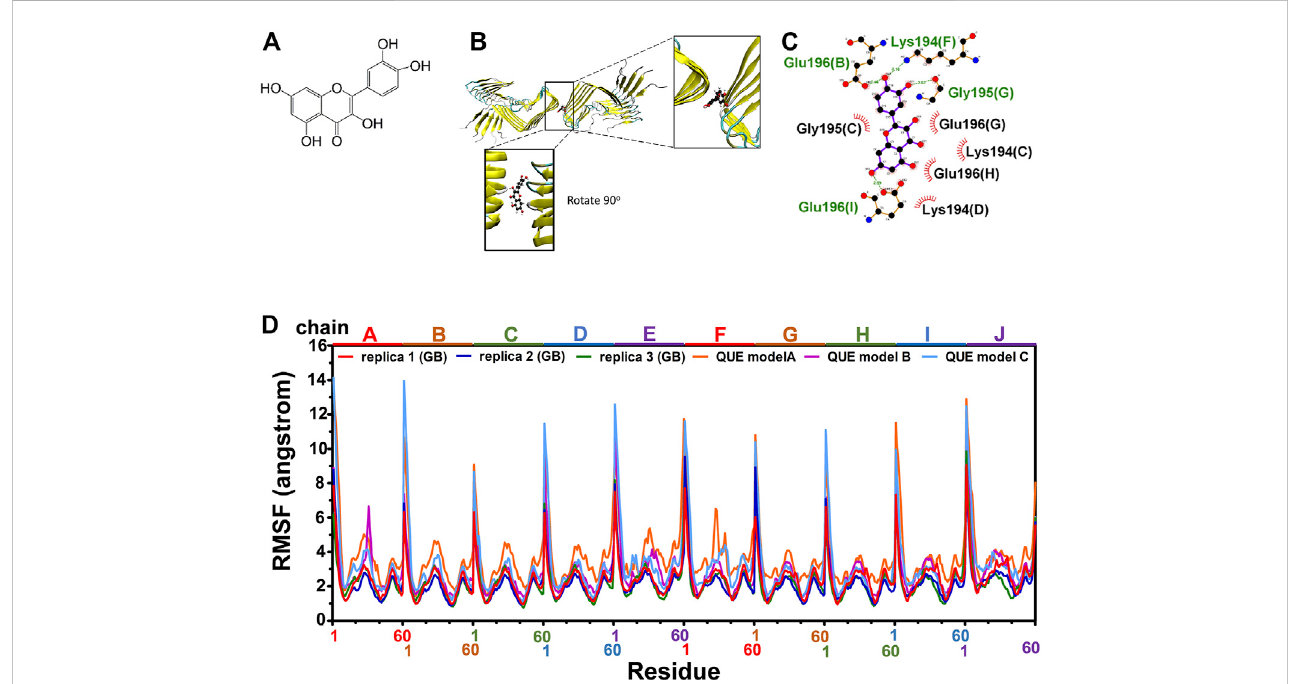
FIGURE 3 Modeling of quercetin-fPrP 170 – 229 complex. (A) The chemical structure of quercetin. (B) The structure of quercetin-fPrP 170 – 229 complex obtained from dockingandMD.Thebindingcavity isshownintheenlargedframe. (C) Interactionnetwork betweenquercetinandproximalresidues.Thealphabetsinsideof the parentheses represent fi bril chains in which the corresponding residue ’ s location. The backbone of quercetin is shown in purple. The residues playing the role of hydrogen bond donor are labeled in green. The residues form non-bonded contact with quercetin are labeled in black with red spoked arcs. (D) RMSF of quercetin-fPrP 170-229 models (QUE models A, B, and C) and RMSF of fPrP 170 – 229 replicas 1, 2, and